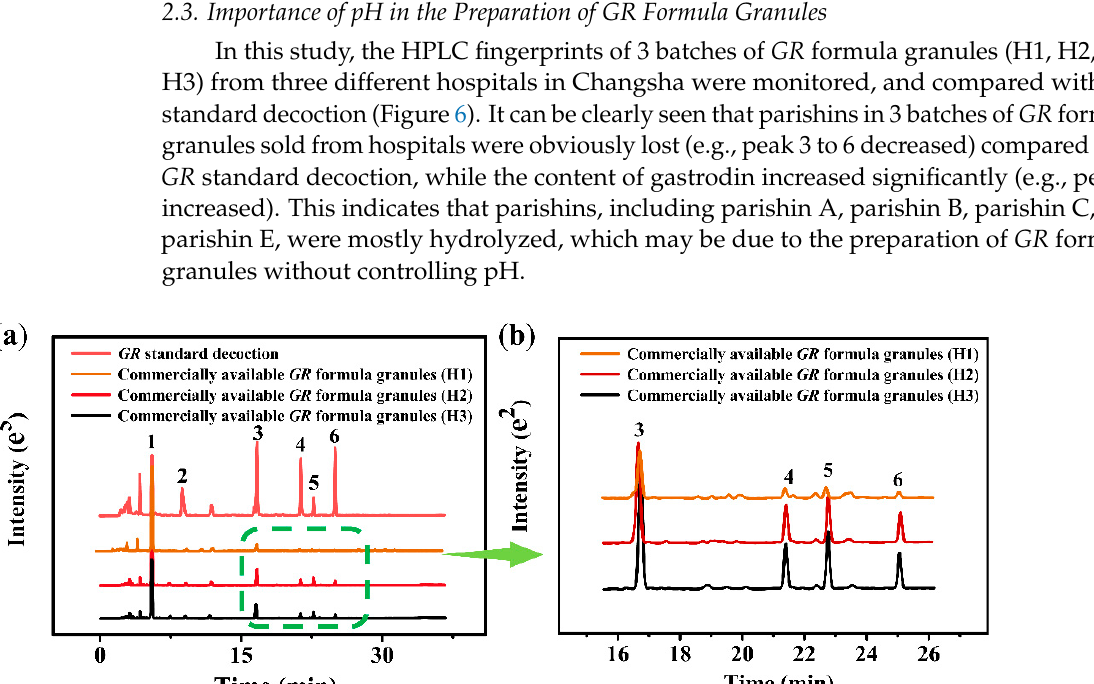
Figure 5. The effect of pH on the transfer rate of six index components, incuding ( a ) gastrodin, ( b ) p -hydroxybenzyl, ( c ) parishin A, ( d ) parishin B, ( e ) parishin C, and ( f ) parishin E in GR standard decoction at weak acid environment.